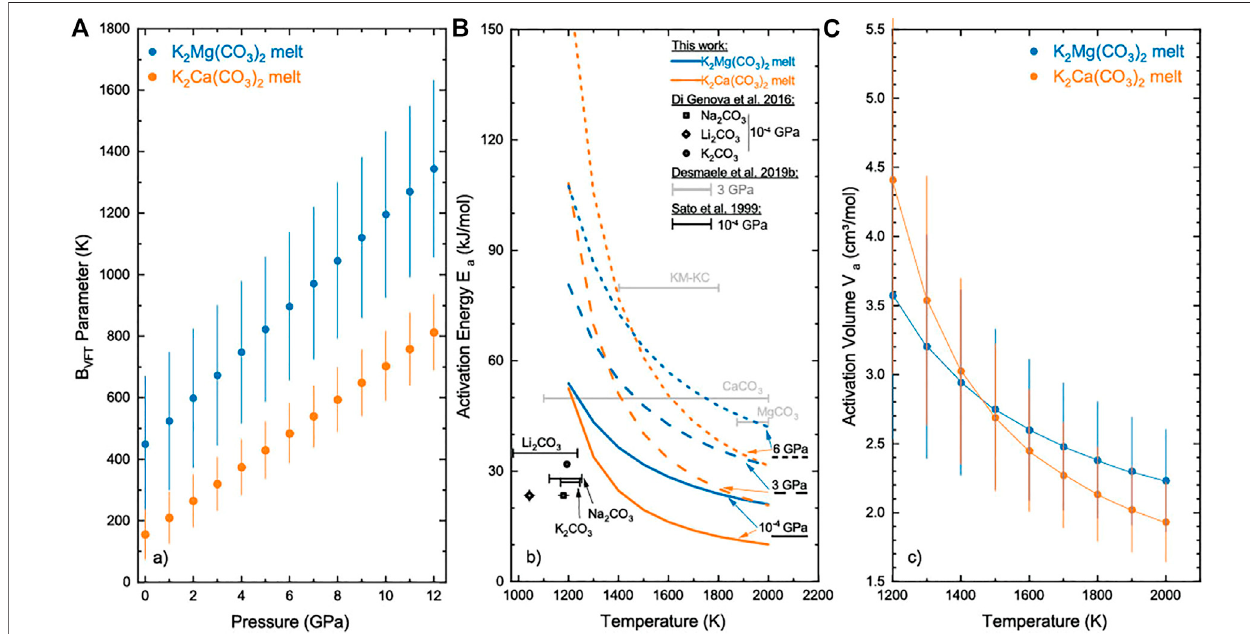
FIGURE 4 | (A) Evolution with pressure of the best- fi t B parameter in the VFT model for K 2 Mg(CO 3 ) 2 (KM) and K 2 Ca(CO 3 ) 2 (KC) melts; (B) Activation energy E a for KM and KC melts as a function of temperature at selected pressures, 10 − 4 , 3 and 6 GPa (this study) and comparison with literature data for alkali and alkaline earth carbonate melts. Symbols and black lines show respectively experimental data for alkali carbonate melts at ambient pressure by Di Genova et al. (2016) and Sato et al. (1999). Grey lines show the temperature-independent (Arrhenian) E a at 3 GPa derived from classical MD simulations for CaCO 3 , MgCO 3 and KM-KC melts by Desmaeleetal.(2019b); (C) Temperaturedependence oftheactivationvolumeV a forKCandKMmelts.Thelinesareguidesfortheeyes.Errorbarsweredeterminedby propagation of undertainties [ Eq.8 ] and correspond to ∼ 20% of the value.